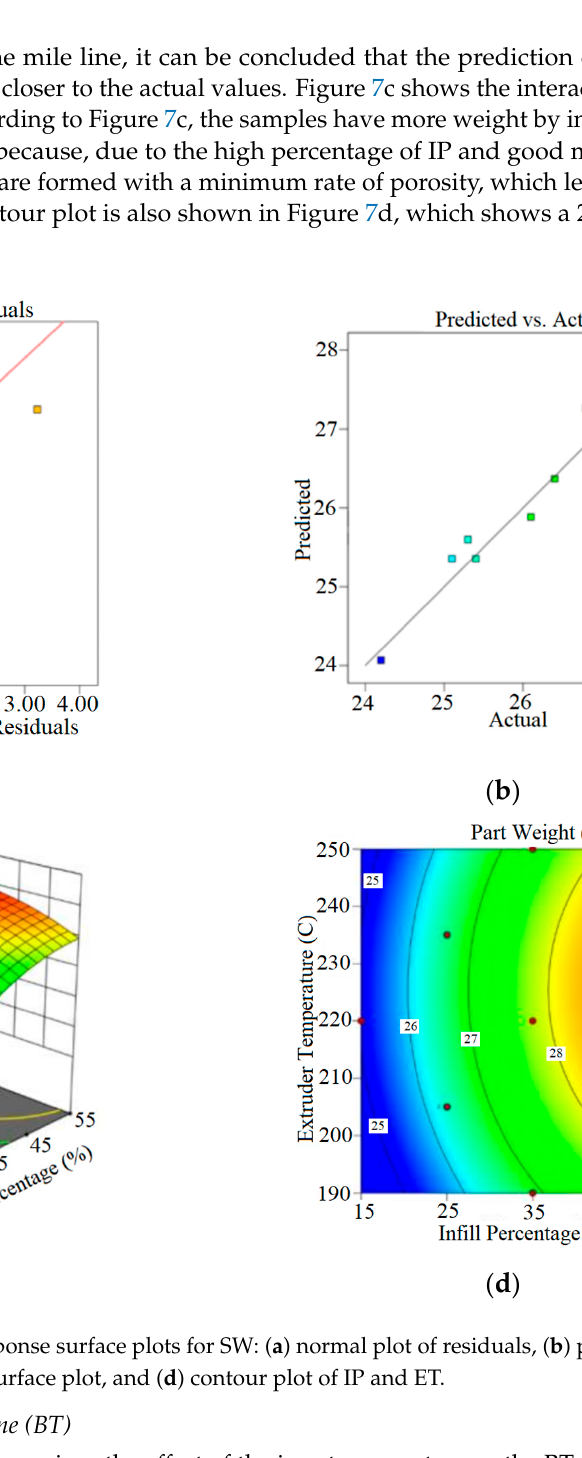
Table 7. Analysis of variance (ANOVA) for SW .